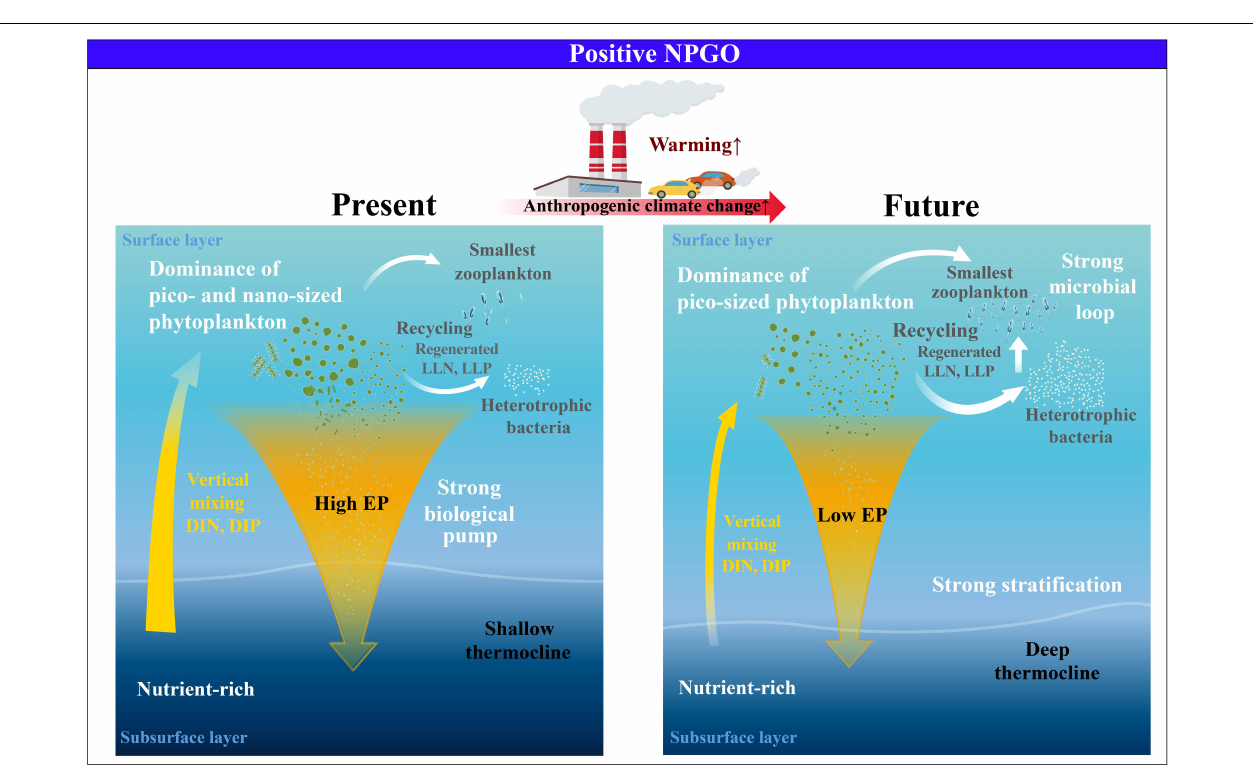
FIGURE 4 | Schematic of the physical–biogeochemical–ecological changes of eastern NPSG in response to future climate